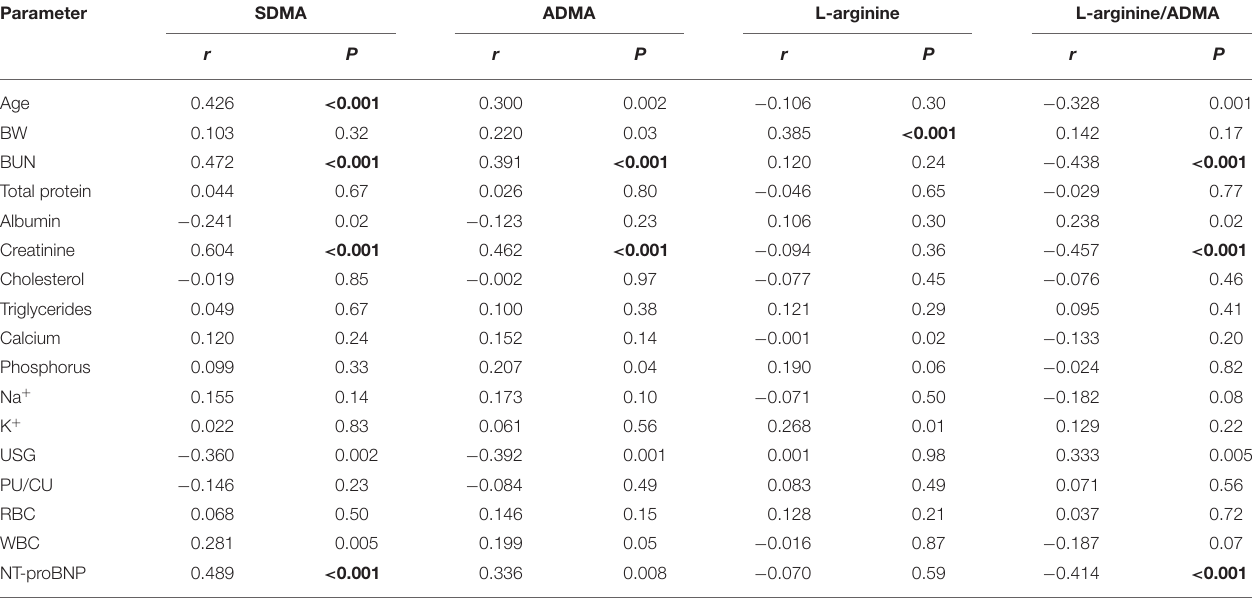
TABLE 3 | Spearman’s ranks correlations index between symmetric dimethylarginine (SDMA), asymmetric dimethylarginine (ADMA), L-arginine, L-arginine/ADMA and demographic and clinical pathology parameters obtained from 11 control dogs and 85 dogs with myxomatous mitral valve disease at different disease stages. Parameter SDMA ADMA L-arginine L-arginine/ADMA